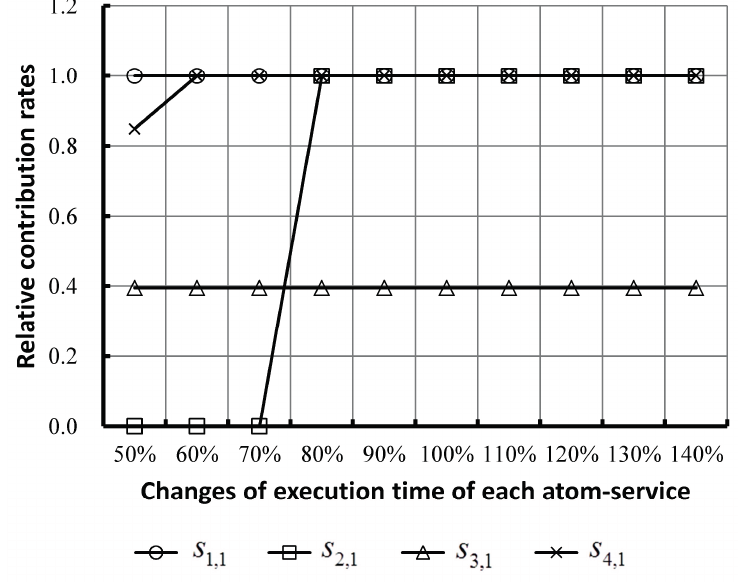
Figure 8. Relative contribution rates on total execution time by each